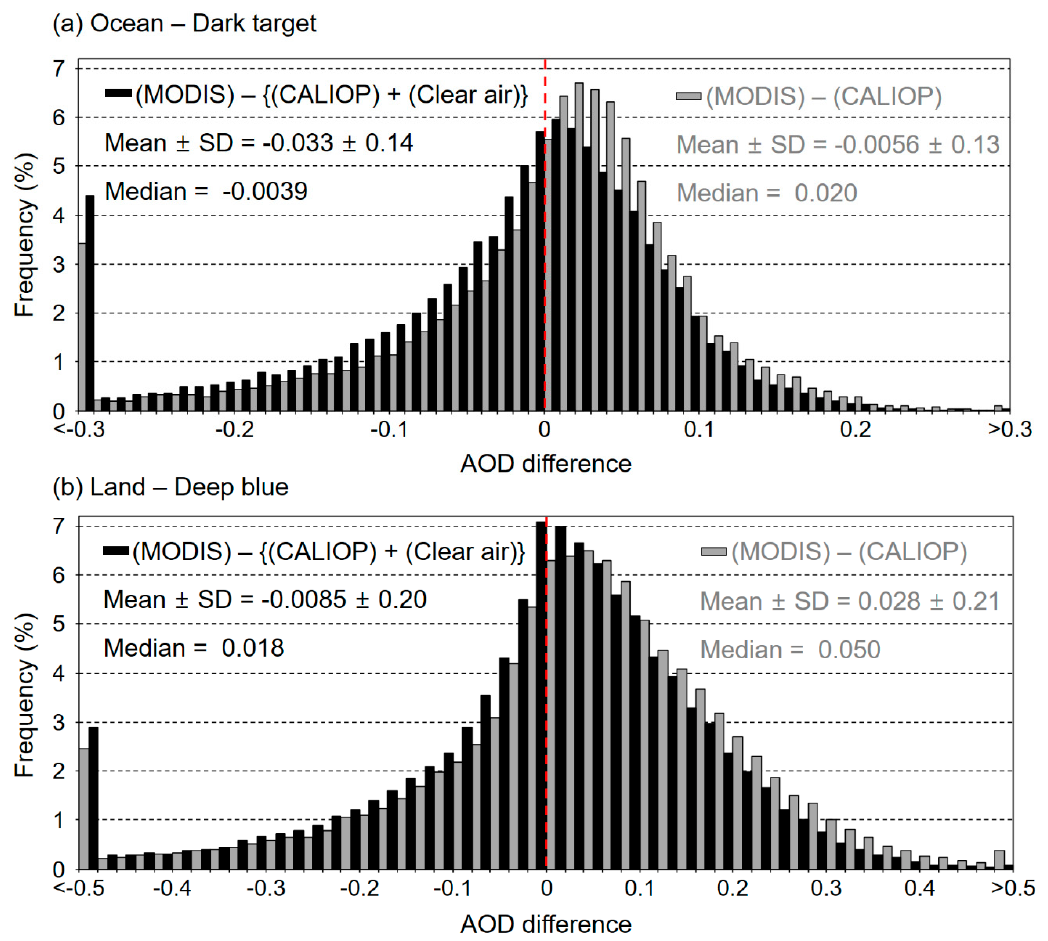
Figure 3. Frequency distribution of AOD difference between CALIOP and MODIS (gray bars) for dust layers used in this study from 2007 to 2011 ( a ) over ocean with MODIS DT AOD and ( b ) over land with MODIS DB AOD. Black bars represent the AOD difference including clear air AOD for CALIOP AOD. CALIOP AOD is from the CALIOP level 2 aerosol product and clear air AOD is retrieved in this study.